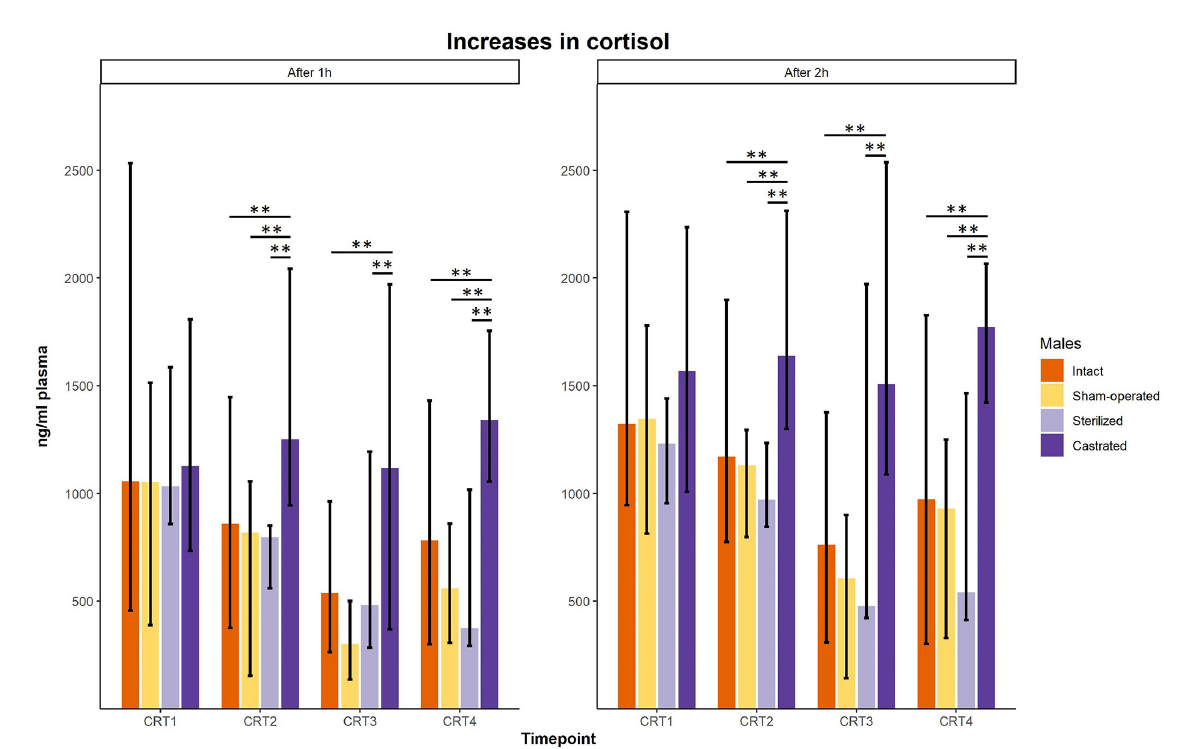
FIGURE4 Response values of cortisol in ng/ml plasma of intact, sham-operated, sterilized and castrated males after 1h (left panel) and after 2h (right panel) during cortisol response tests. Data are presented as medians, minimum and maximum values. CRT1, cortisol response test before surgery; CRT2, cortisol response test about 4 days before start of experiment (1 male and 2 females were put together); CRT3, cortisol response test 1 week after start of experiment; CRT4, cortisol response test 2 weeks after start of experiment. Statistics: Kruskal-Wallis tests,